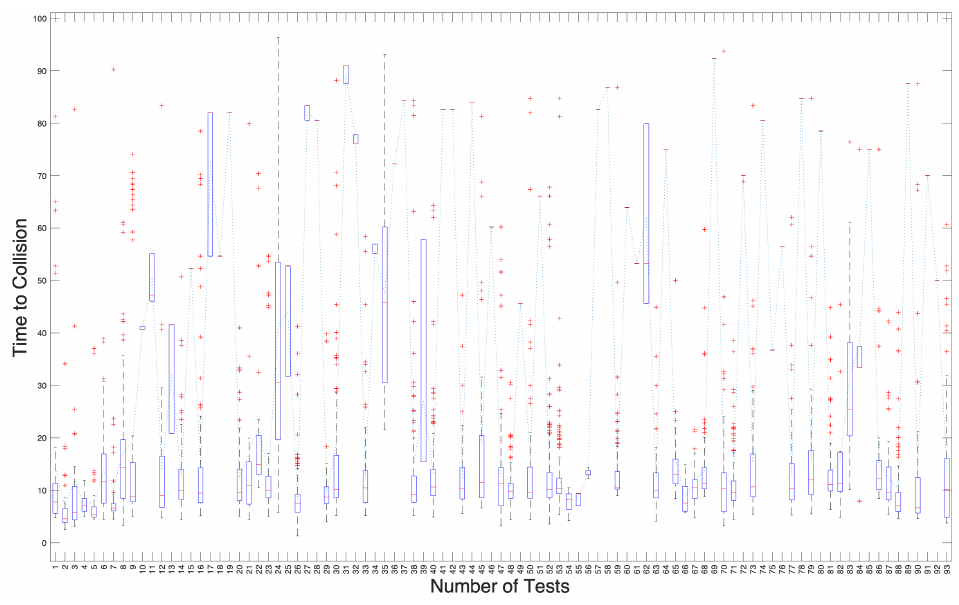
Figure 25. Human recognition